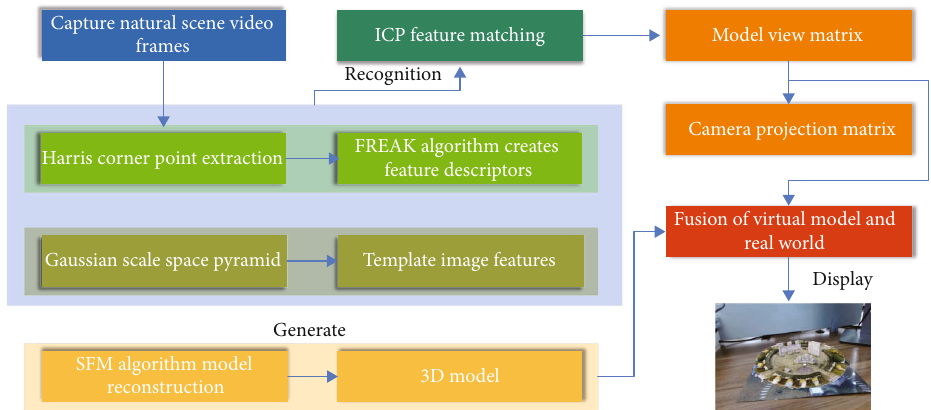
Figure 1: Augmented reality fusion method implementation process.